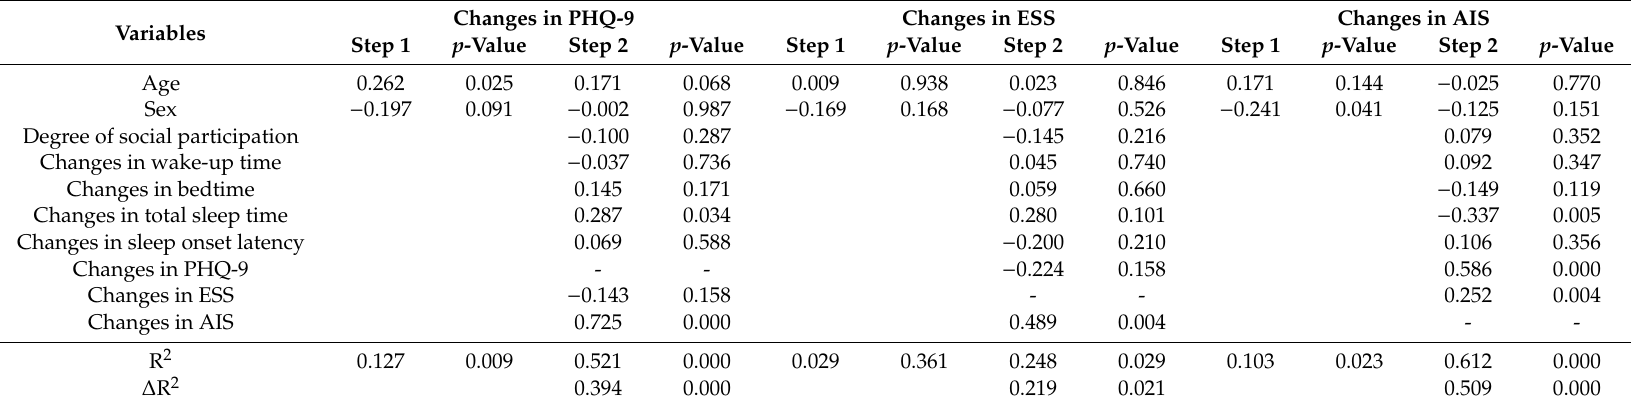
Table 2. Results of multiple regression analysis in the strong self-isolation group.